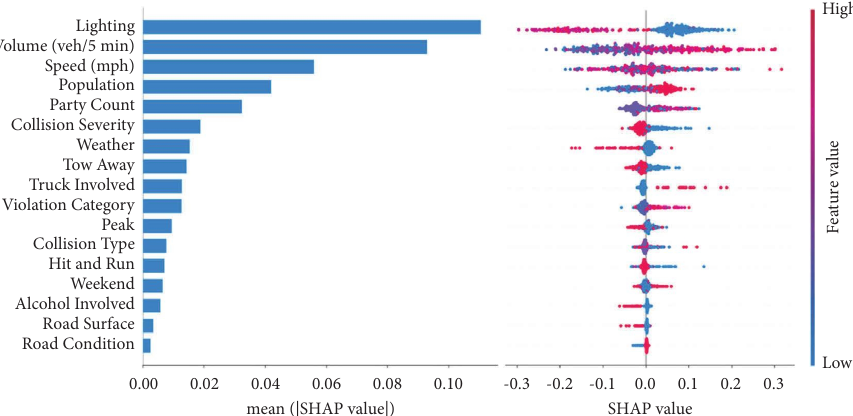
Figure 3: Global importance of independent variables and a summary of local explanations for the time